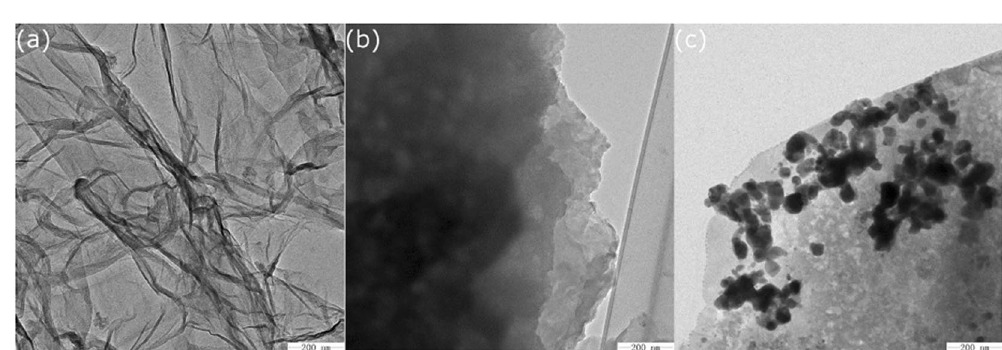
Figure 2. DSC-TG record of GAD (7.2 mg) measured in nitrogen.